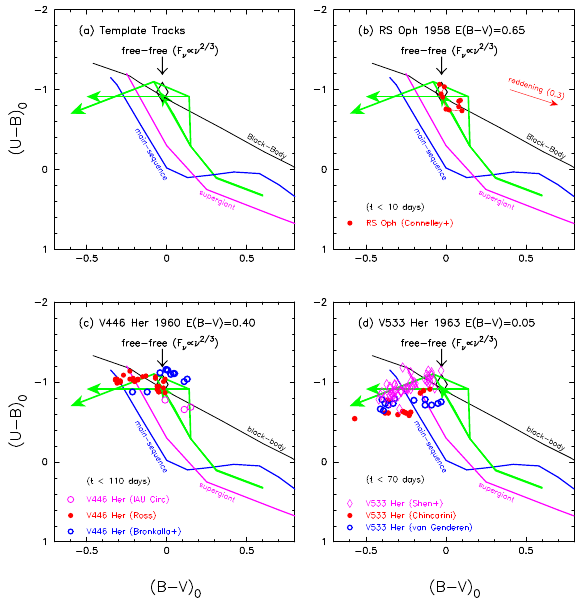
Figure 4: Color-color evolution of (a) template 8 no-